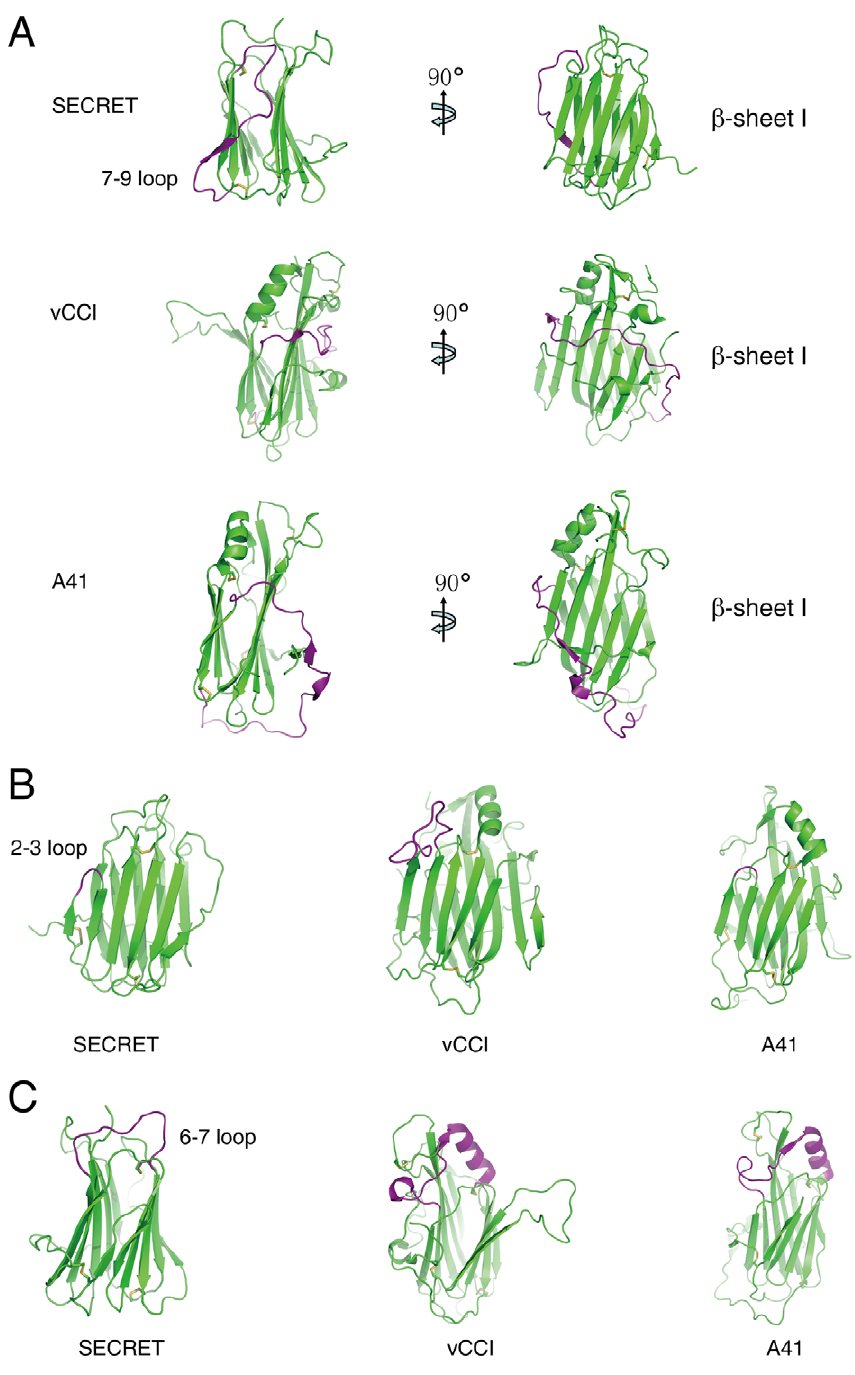
Figure 2. Structural comparison of the SECRET domain with vCCI and A41. (A) The conformational change of the 7–9 loop colored with purple. (B) The conformational change of the 2–3 loop colored with purple. (C) The conformational change of the 6–7 loop colored with